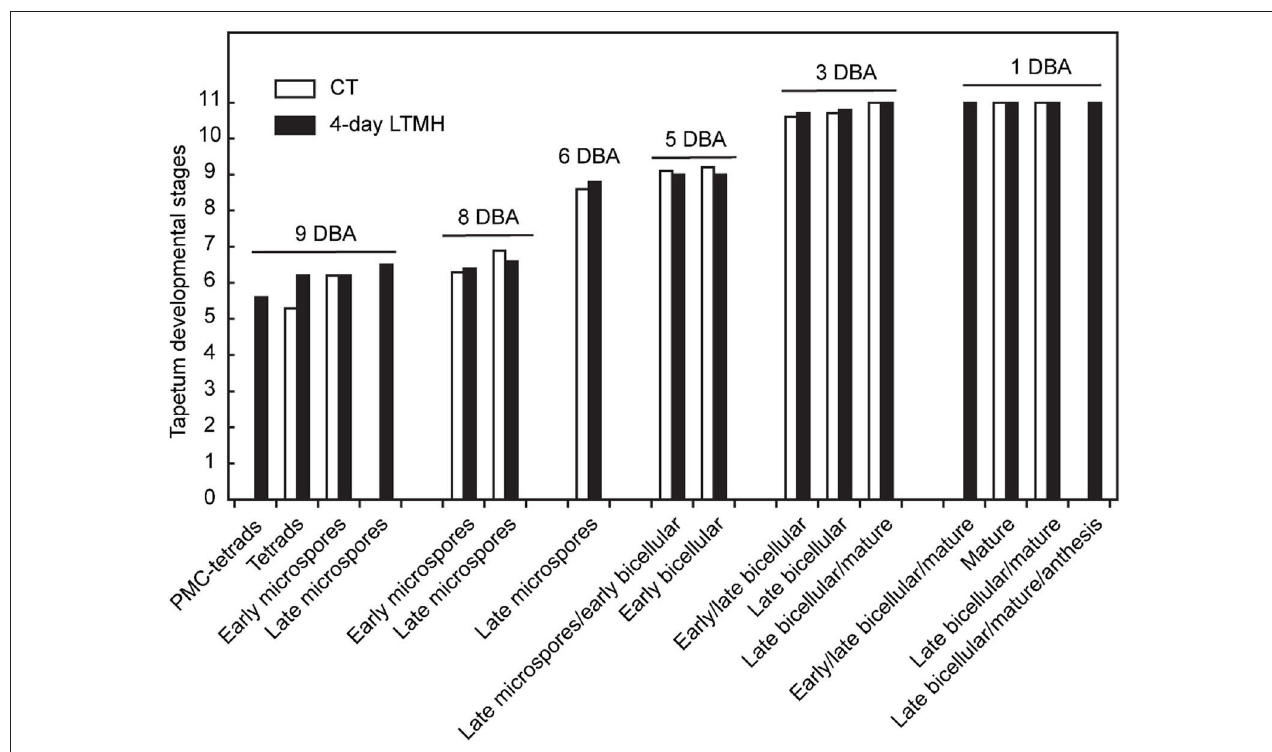
FIGURE 5 | Comparison of tapetum development between control and 4-day long-term mild heat treatment. Long-term mild heat (LTMH) or control temperature (CT) were applied for 4 days, and flowers that were at the 10-DBA stage on the last day of the treatment (i.e., they were treated from 13 DBA to 10 DBA) were labeled and then sampled on subsequent days (at stages of 9, 8, 6, 5, 3, and 1 DBA) for cytological analysis. For each flower stage, average tapetum developmental stage (see Supplementary Table S2 ) was plotted against pollen developmental stages of the samples (see Supplementary Table S1 ). For each stage per treatment, 100 to 140 locules were analyzed. pMC, pollen mother